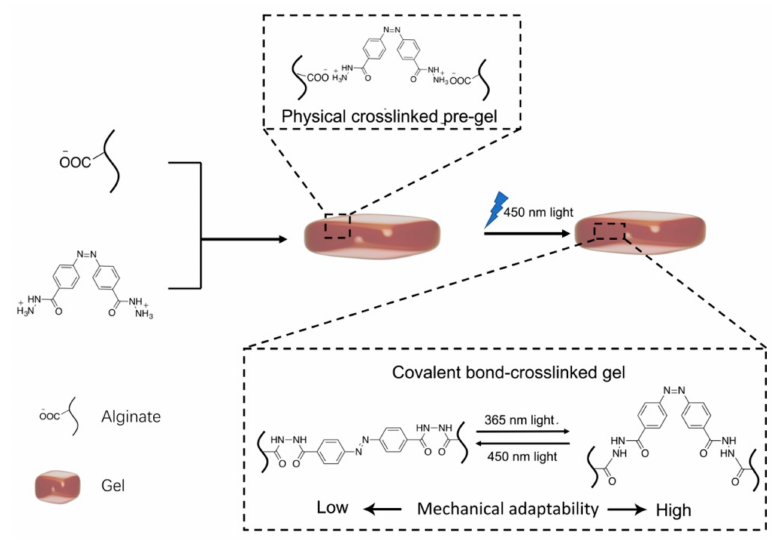
Figure 1. The scheme of the fabrication of Azo-alginate